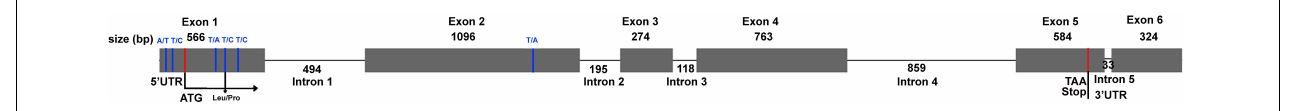
FIGURE 5 | Candidate gene LOC109334326 DNA structure. Introns and exons are represented with continuous lines and gray rectangular boxes. Start codon and stop codon are marked with red lines. 5’-UTR and 3’-UTR are shown in the figure. SNP variations are marked with blue lines and letters (83A:476 on the left, and P27255 on the right). One amino acid substitution is indicated in the figure.